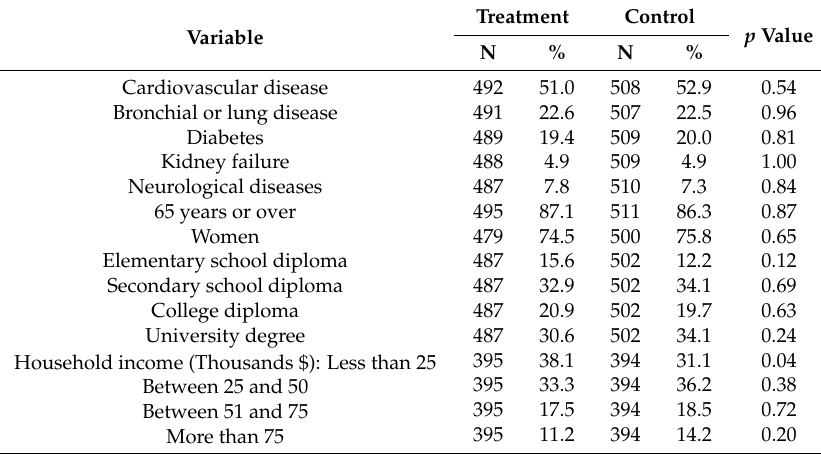
Table 1. Participant